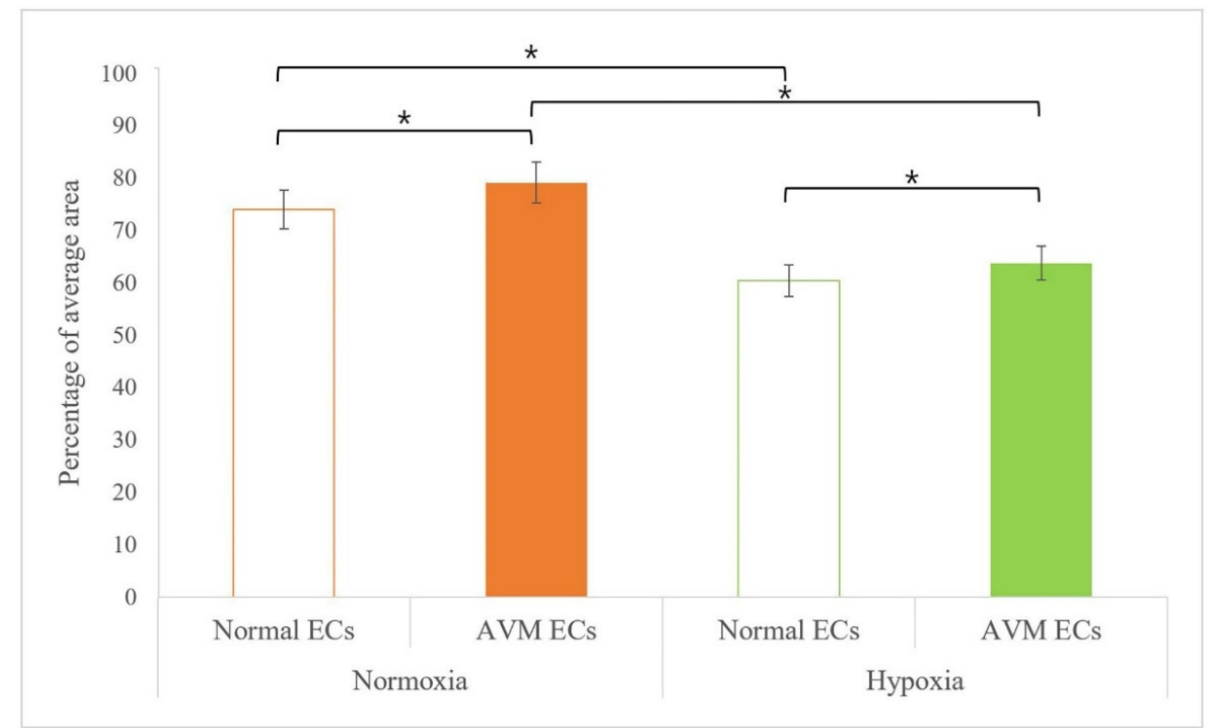
Figure 2. Quantitative comparison of CD31 immunoreactivity after incubation under each condition for 14 h. Pixel densities were analyzed using the ImageJ software. Compared to that of normoxia, both AVM ECs and normal ECs showed lower percentage areas of immunoreactivity in hypoxia. Compared to that of normal ECs, AVM ECs showed a higher percentage area of immunoreactivity in normoxia and hypoxia. * p < 0.05. AVM, arteriovenous malformation; EC, endothelial cell.